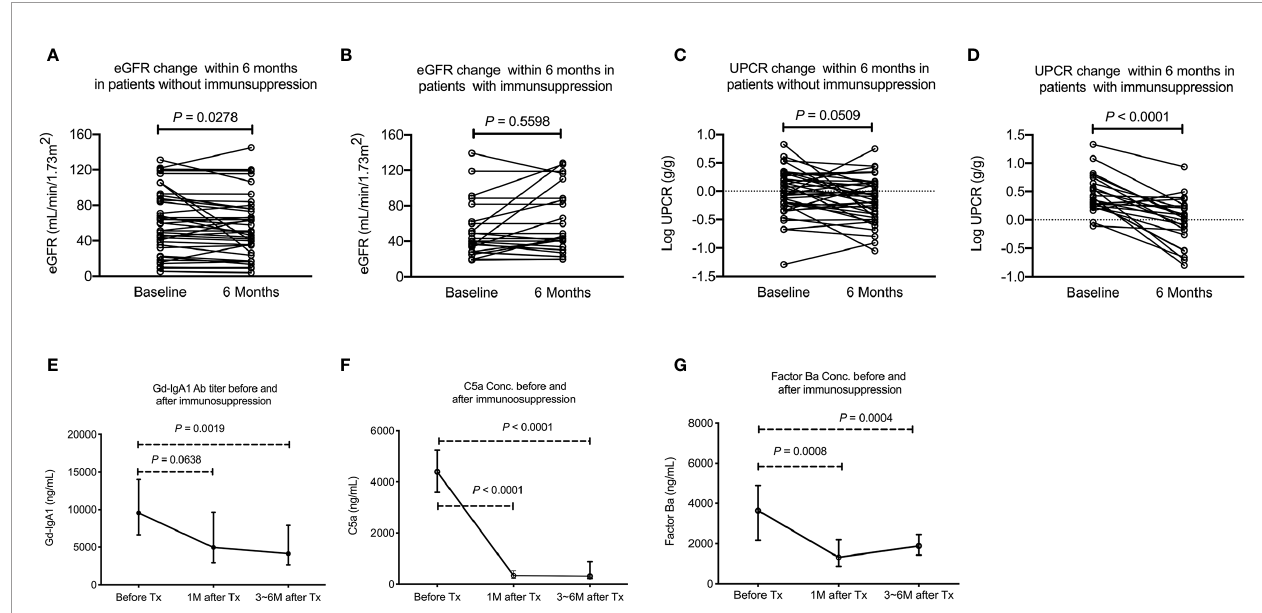
FIGURE 5 | Decreased activation of alternative and terminal complement pathway and stabilized renal function after immunosuppression. (A) eGFR decreased slightly among patients who did not receive immunosuppression ( P = 0.028). (B) No change in eGFR among patients received immunosuppression. (C) UPCR tended to decrease slightly among patients who did not receive immunosuppression ( P = 0.051). (D) UPCR decreased signi fi cantly in patients who received immunosuppression ( P < 0.0001). (E) Plasma Gd-IgA 1 level tended to decrease 1 months after immunosuppression (N = 17, P = 0.0638) and 3~6 months after immunosuppression (N = 20, P = 0.0019). (F) Plasma C5a signi fi cantly decreased 1 (N = 17, P < 0.0001) and 3~6 months after immunosuppression (N = 20, P < 0.0001). (G) Plasma factor Ba level signi fi cantly decreased 1 (N = 17, P = 0.0008) and 3~6 months after immunosuppression (N = 20, P = 0.0004). UPCR, urinary protein to creatinine ratio; eGFR, estimated glomerular fi ltration